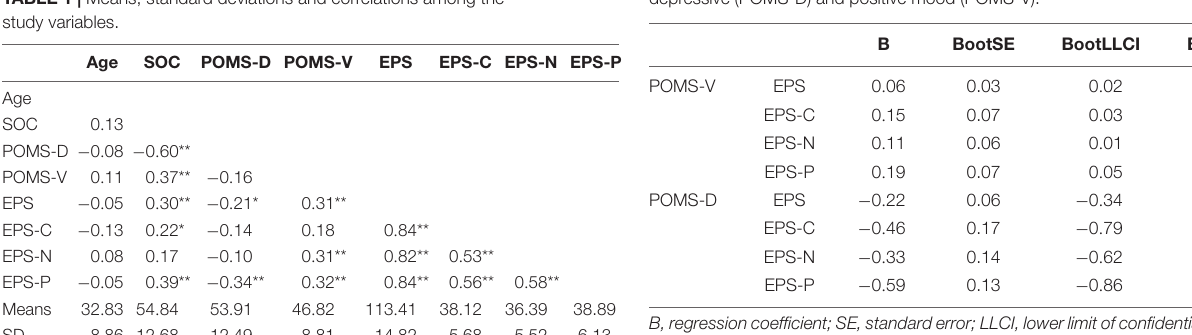
TABLE 2 | Indirect effect of SOC on the association between empathy (EPS) and depressive (POMS-D) and positive mood